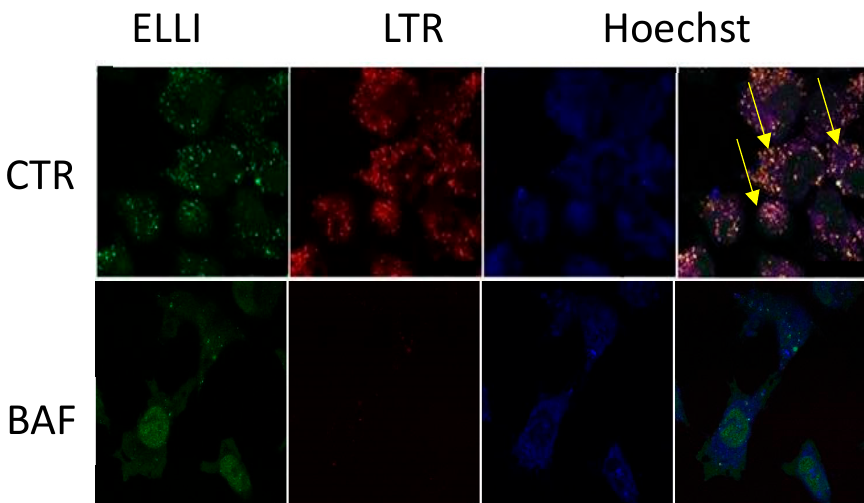
Figure 3. Confocal microscope images demonstrate co-localization (yellow) of ellipticine (green) and LysoTracker (red), (marker of the acidic lysosomal compartment) in UKF-NB-4 cells. Ellipticine is present (sequestrated) in lysosomes. Cells were incubated with ellipticine with or without bafilomycin A (BafA) Pretreatment of the UKF-NB-4 cells with bafilomycin A prior to ellipticine decreased amounts of formed vacuoles. Nuclei were stained with Hoechst 33342 (Hoechst). Yellow arrows- co-localization of ellipticine a LysoTracker. Original magnification 1000 × . Photo M. Belhajova, J. Hrabeta.